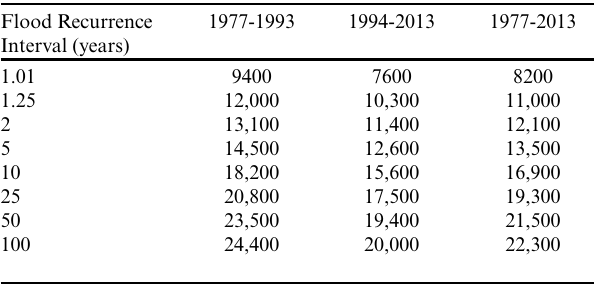
Table 3 . Calculated flood recurrence intervals, rounded to nearest 100 m³/s, for the Yukon River at Stevens Village for 2 phases of the period of record and the entire 37 years of